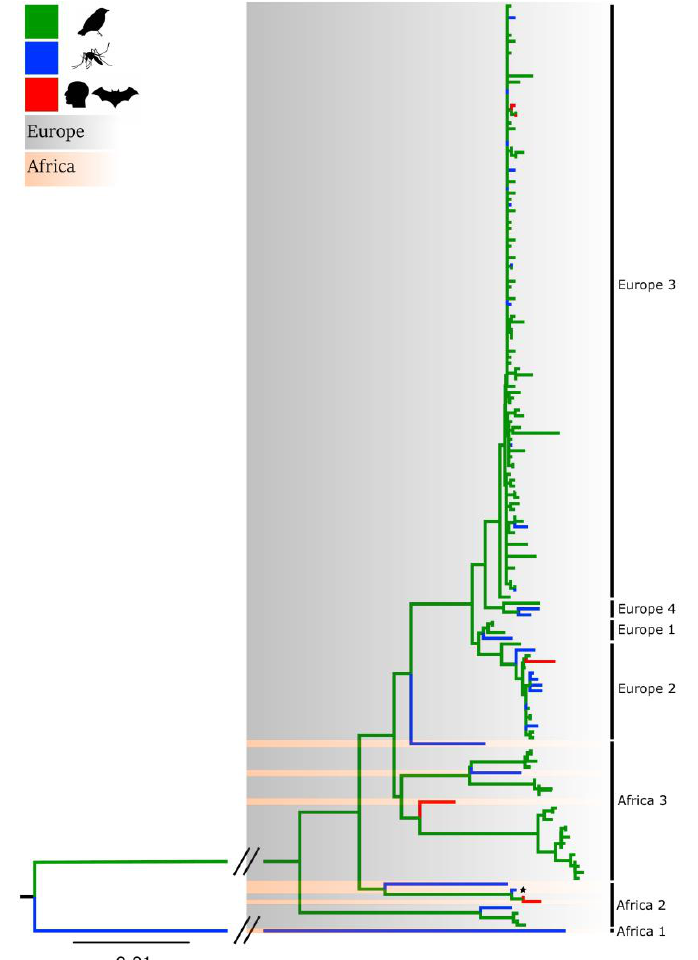
Figure 1. Maximum-likelihood phylogenetic tree analysis of the NS5 gene of USUV strains ( n = 158) circulating worldwide. Strains isolated from birds, mosquitoes and mammals are indicated in green, blue and red, respectively. African and European variants are shaded in pink and gray, respectively. The prototype SAAR-1776 strain is indicated by a star. The bar at the bottom of the tree denotes evolutionary distance, as number of base substitutions per site. The interrupted branches (indicated by oblique lines) were shortened by 50% for better graphic representation. The list of USUV strains used to generate the tree are provided in Supplemental Materials: Table S1.